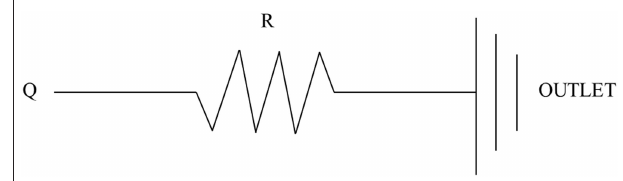
FIGURE 2 | Scheme of the LPM. Outlet boundary condition: a lumped parameter model with only one resistance is coupled to each